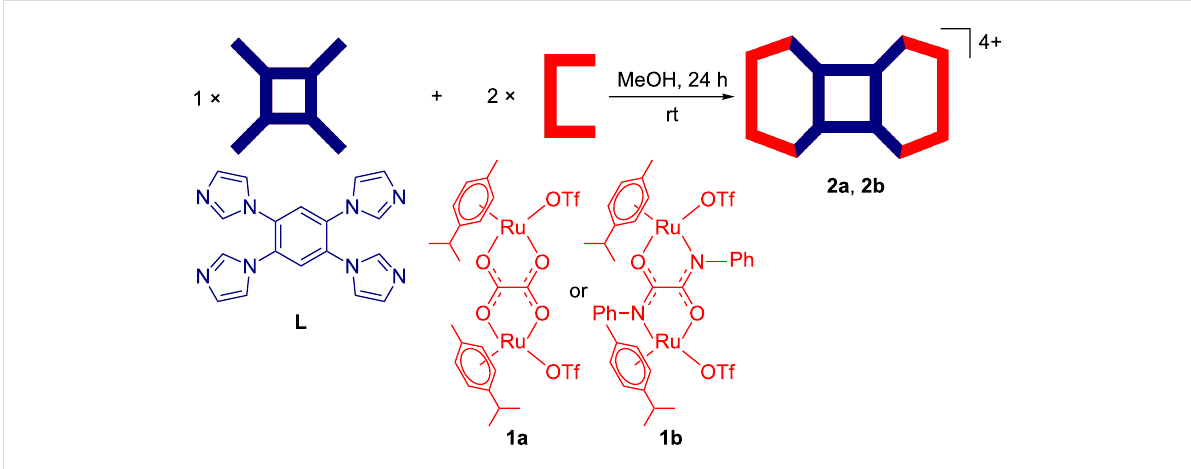
1602 cm − 1 ( 2b ) corresponding to the symmetrical stretching frequencies ( ν CO ) of the carbonyl groups of the coordinated bis- bidentate oxalato ( 2a ) or N , N' -diphenyloxamidato ( 2b ) ligands. These bands, due to symmetrical stretching ( ν CO ) in the complexes, are slightly shifted to a higher energy region compared to those of the starting acceptors ( 1a , ν CO = 1623.7 cm − 1 ; 1b , ν CO = 1605.0 cm − 1 ) due to the ligand-to- metal coordination. The appearance of a single peak in the 19 F NMR spectrum at − 81.03 ppm ( 2a ) or − 79.8 ppm ( 2b ) indi- cated the presence of triflate counter anions in the same chem- ical environment in the resultant complexes (Figure 1 and Figure S3, Supporting Information File